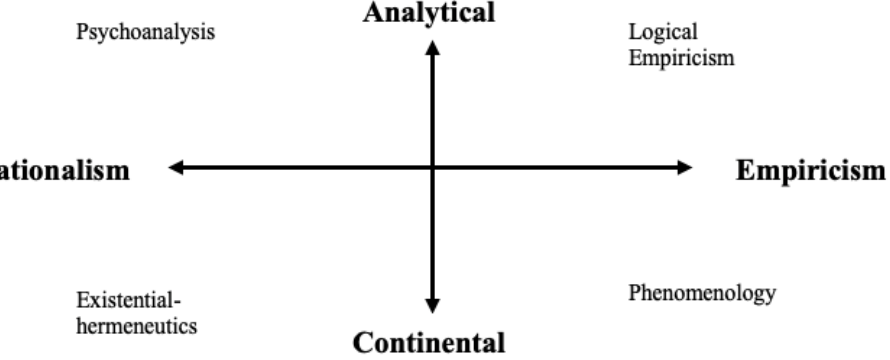
Figure 1: Contemporary Schools of Metascience: A Simplified